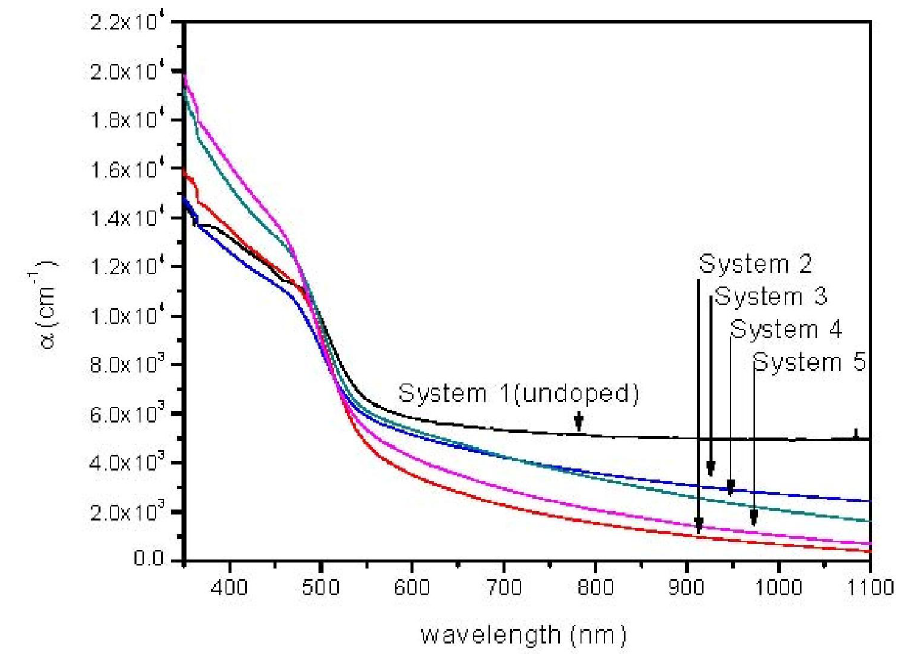
Figure 3. Absorption spectra for all